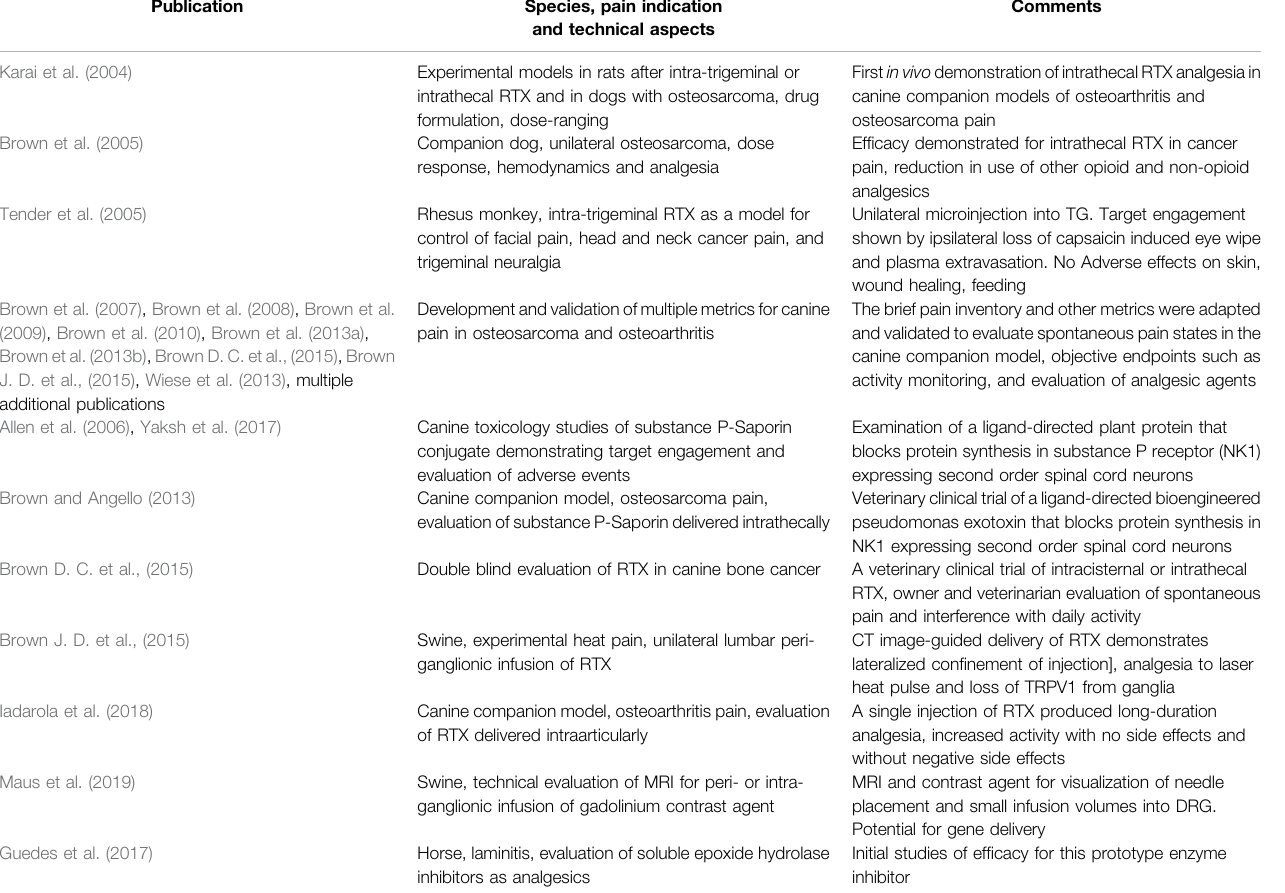
TABLE 2 | Examples of canine companion and other large animal models in pain research